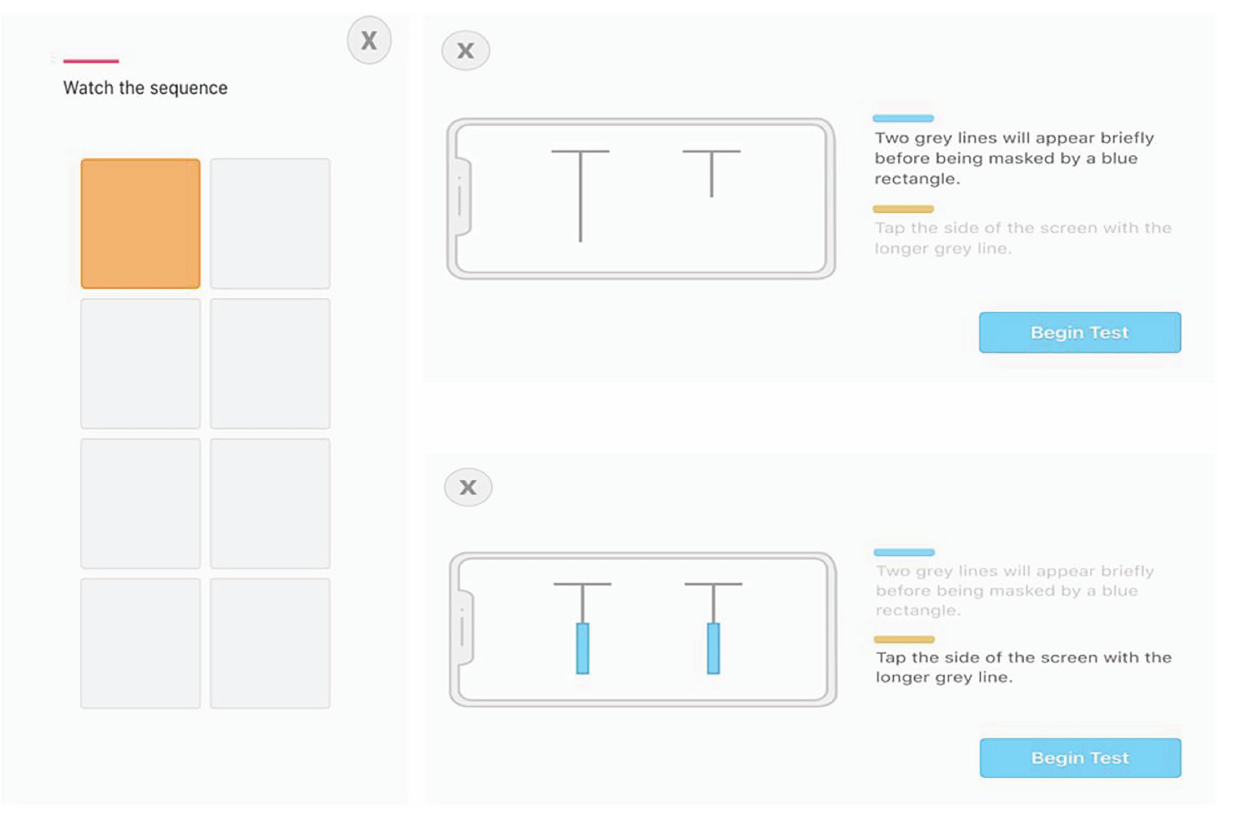
FIGURE 1 | Screenshots of Working Memory (left) and Inspection Time (right)